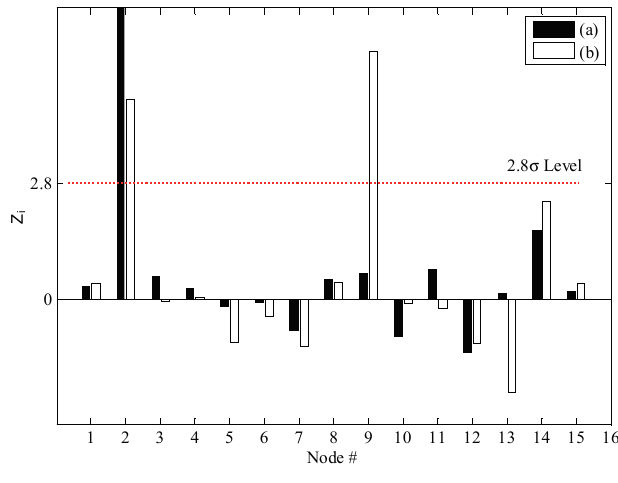
Figure 5. Results of damage detection using the NULS curvature method: ( a ) DC1 and ( b ) DC2.